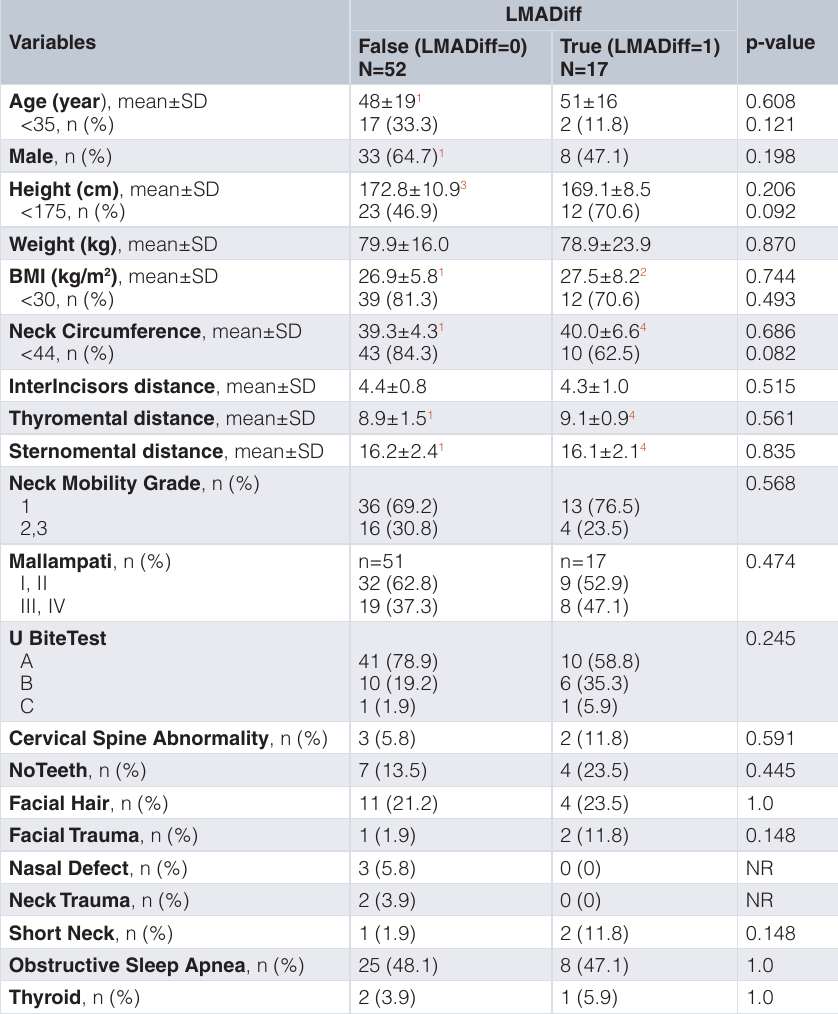
Table 1. Preoperative patient characteristics by LMADiff status.